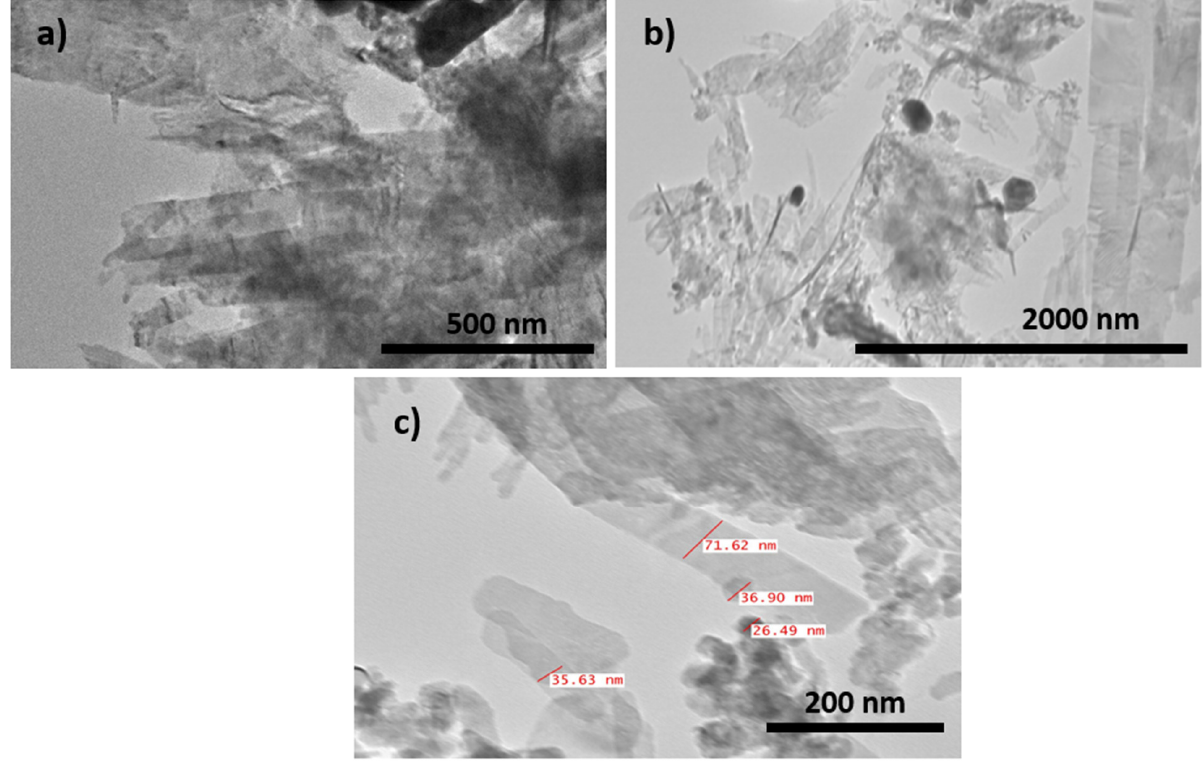
Figure 5. TEM image of Ag-rGO@CuO nanocomposite at different magnifications ( a ) 10,000× ( b ) 15,000× and ( c ) 80,000×.